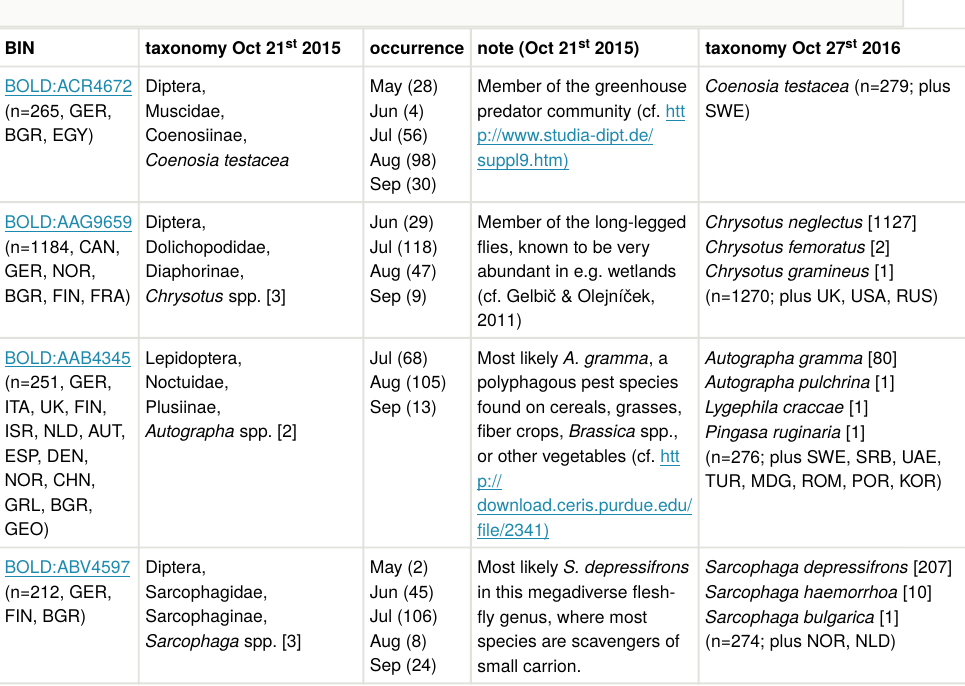
Ten most common BINs in samples from GMTPZ with BIN information from BOLD (Oct 21 2015 and Oct 27 2016): number of individuals and country of origin, taxonomy [number of species, if BIN discordant], occurrence in GMTPE samples and a general note. The hyperlink leads to the respective BIN page on BOLD with information on the geographical distribution of specimens and images of